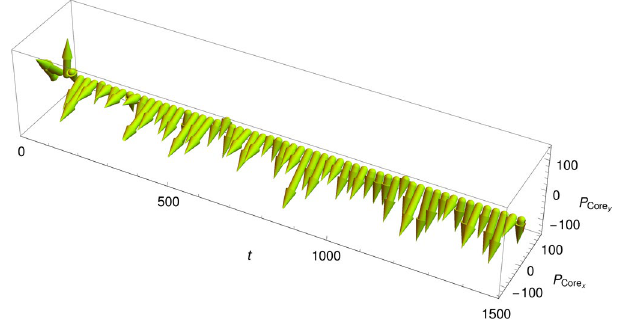
Figure 8. Instantaneous total momentum P Core of the particles trapped in the self-consistent potential wells as a function of time for N = 25000 particles (same parameters as in Fig. 2). The fraction of trapped particles forming the crystal-like structure remains equal to about 70% during the whole QSS stage for the initial conditions (20) considered in the present study.